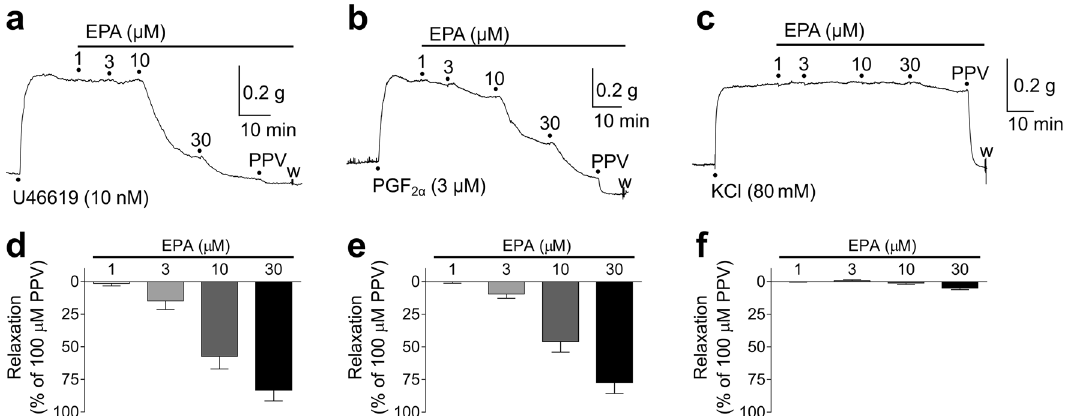
Figure 1. Representative traces showing relaxant responses to 1–30 μM eicosapentaenoic acid (EPA) on porcine basilar artery tonic contractions induced by 10 nM U46619 ( a ), 3 μM prostaglandin (PG) F 2α ( b ), and 80 mM KCl ( c ); quantified data of relaxant responses to 1–30 μM EPA on the contractions induced by 10–30 nM U46619 ( d ), 3–6 μM PGF 2α ( e ), and 80 mM KCl ( f ). Data are presented as mean ± SEM (n = 7 ( d , e ) and n = 6 ( f )). ● : each drug application. PPV: 100 μM